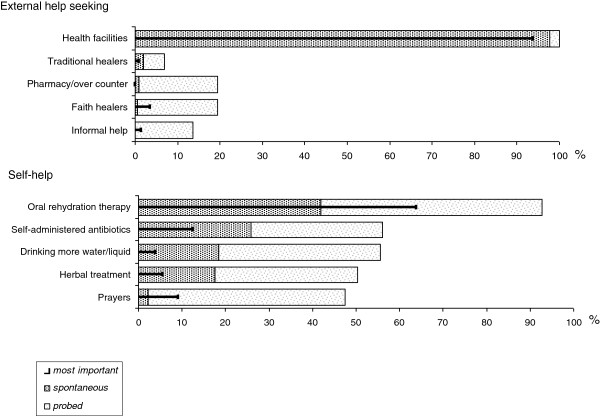
Treatment seeking (%).